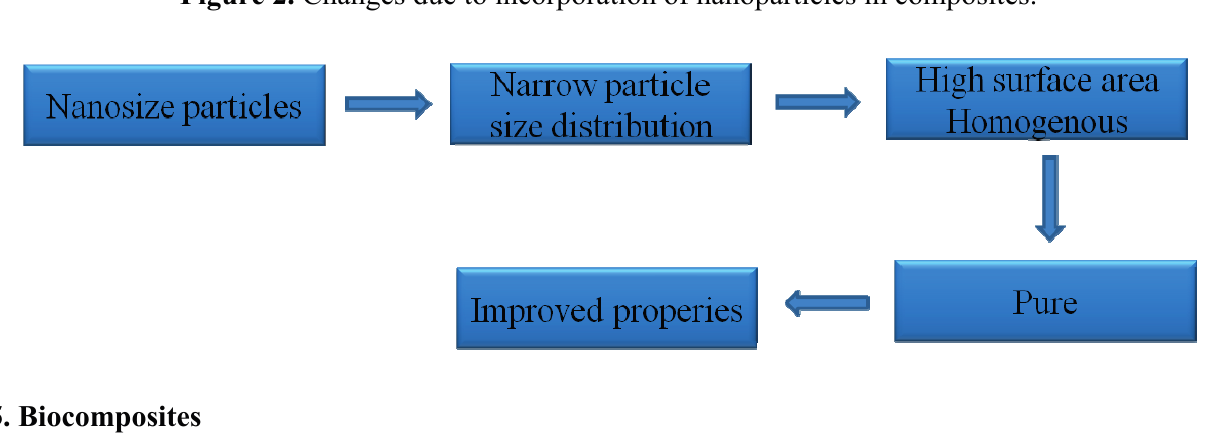
Figure 2. Changes due to incorporation of nanoparticles in